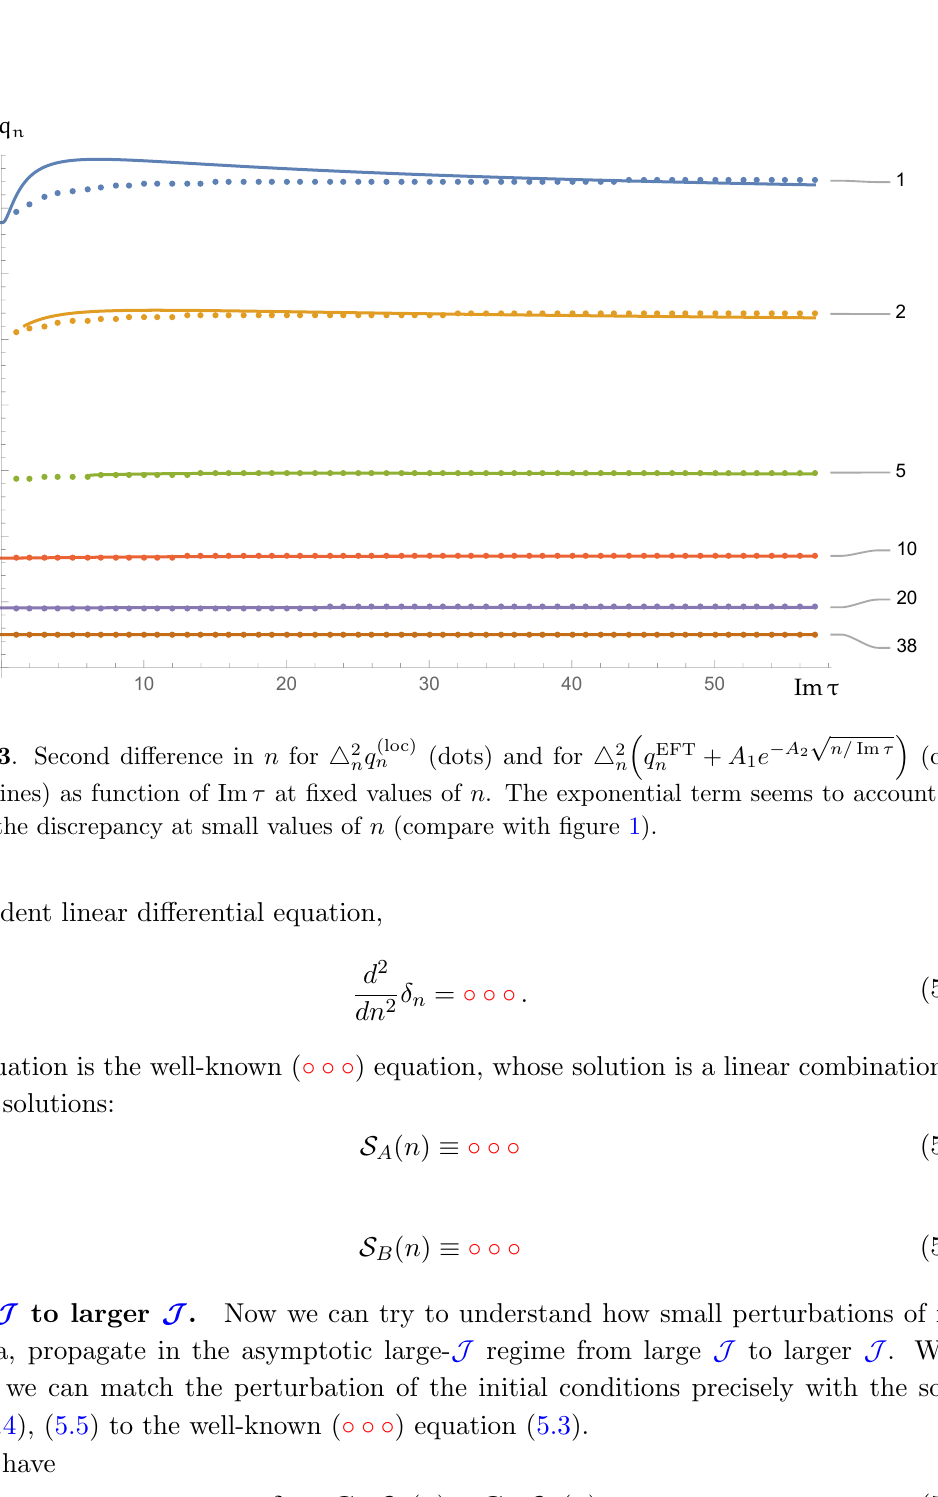
n -dependent linear di(cid:11)erential